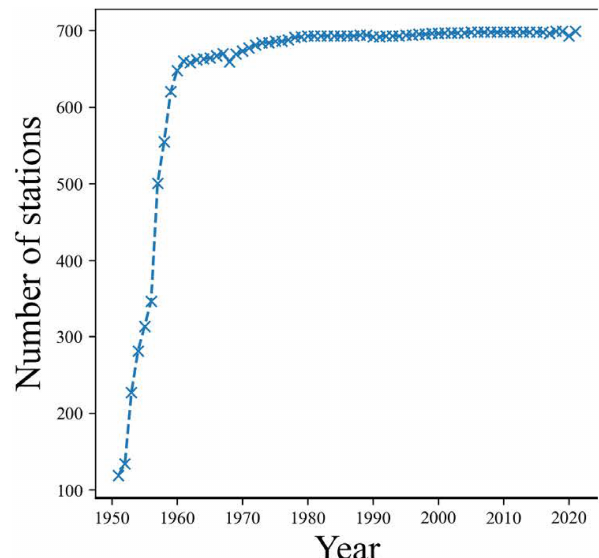
Figure 2. Changes in the number of meteorological stations in China. There were only 119 stations in 1951. This number increased rapidly from 1951 to the early 1960s, and the number of stations re- mained stable after 2000. To ensure data quality, we used the latter 31 years (from 1990 to 2020) to construct the